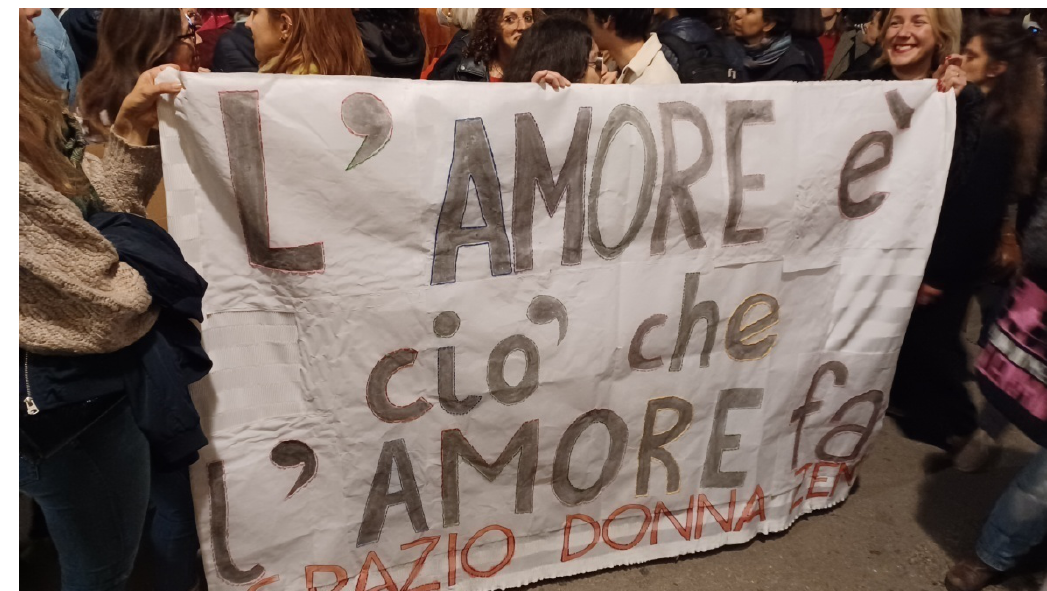
Fig. 5 : 25 November 2022, at the protest in Palermo